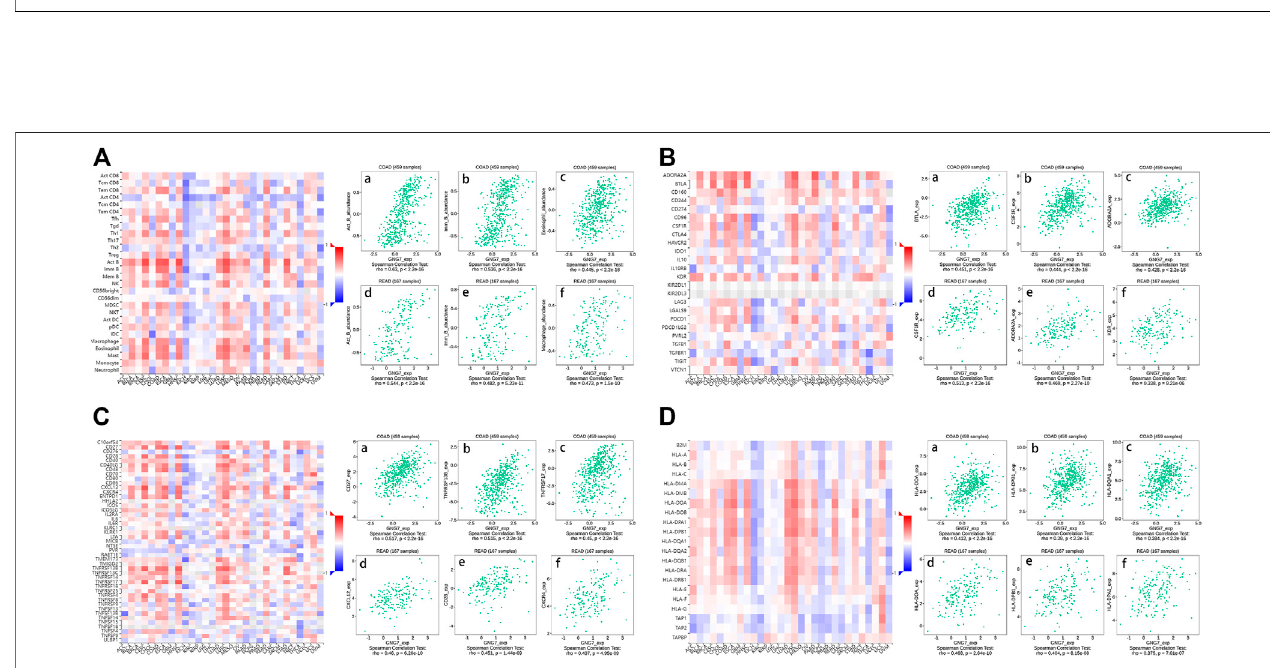
FIGURE 8 | Spearman ’ s correlationofGNG7with lymphocytesand immunomodulators in TISIDBdatabase. (A) Relationship between theabundance ofTILsandGNG7 expression in different human cancers. Top 3 TILs displaying the greatest correlation with GNG7 expression in COAD (A – C) and READ (D – F) . (B) Relationship between the abundance of immunoinhibitors and GNG7 expression in different human cancers. Top 3 immunoinhibitors displaying the greatest correlation with GNG7 expression in COAD (A – C) and READ (D – F) . (C) Relationship between the abundance of immunostimulators and GNG7 expression in different human cancers. Top 3 immunostimulators displayingthegreatestcorrelationwithGNG7expressioninCOAD (A – C) andREAD (D – F) . (D) RelationshipbetweentheabundanceofMHCmoleculesandGNG7expressionin different human cancers. Top 3 MHC molecules displaying the greatest correlation with GNG7 expression in COAD (A – C) and READ (D – F) .